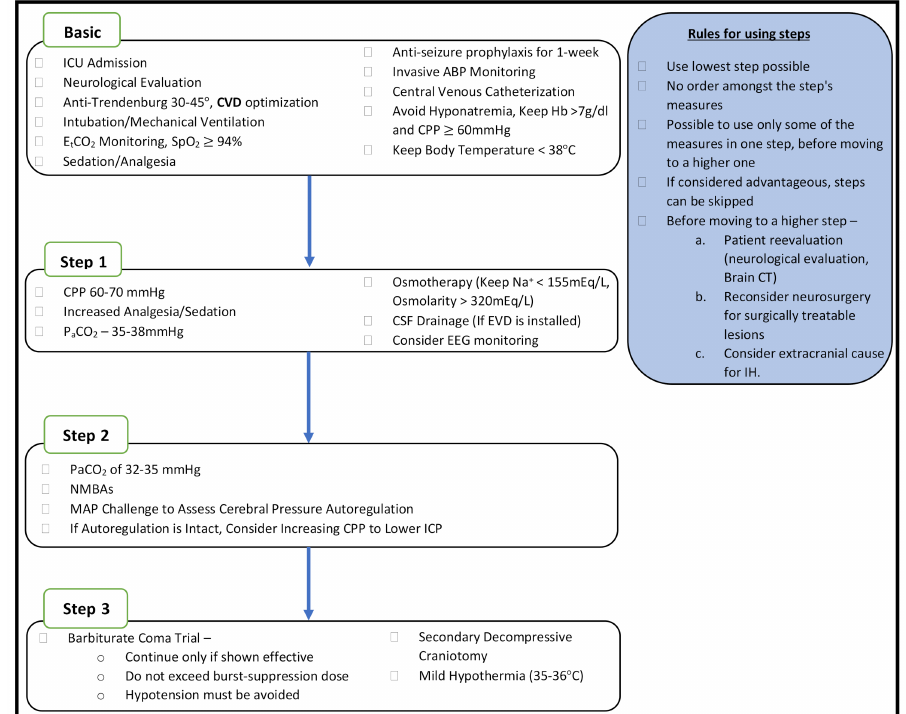
Figure 1. Intracranial pressure monitor-based management algorithm for severe traumatic brain injury patients (modified from Hawryluk GWJ et al. [57]). ICU, intensive care unit; CVD, cerebral venous drainage; EtCO 2 , end tidal carbon dioxide; SpO 2 , arterial oxygen saturation; ABP, arterial blood pressure; CPP, cerebral perfusion pressure, PaCO 2 , arterial partial pressure of carbon dioxide; CSF, cerebral spinal fluid; EVD, external ventricular drain; EEG, electroencephalogram; NMBA, neuromuscular blocking agent; MAP, mean arterial pressure; ICP, intracranial pressure; CT, computed tomography; IH, Intracranial